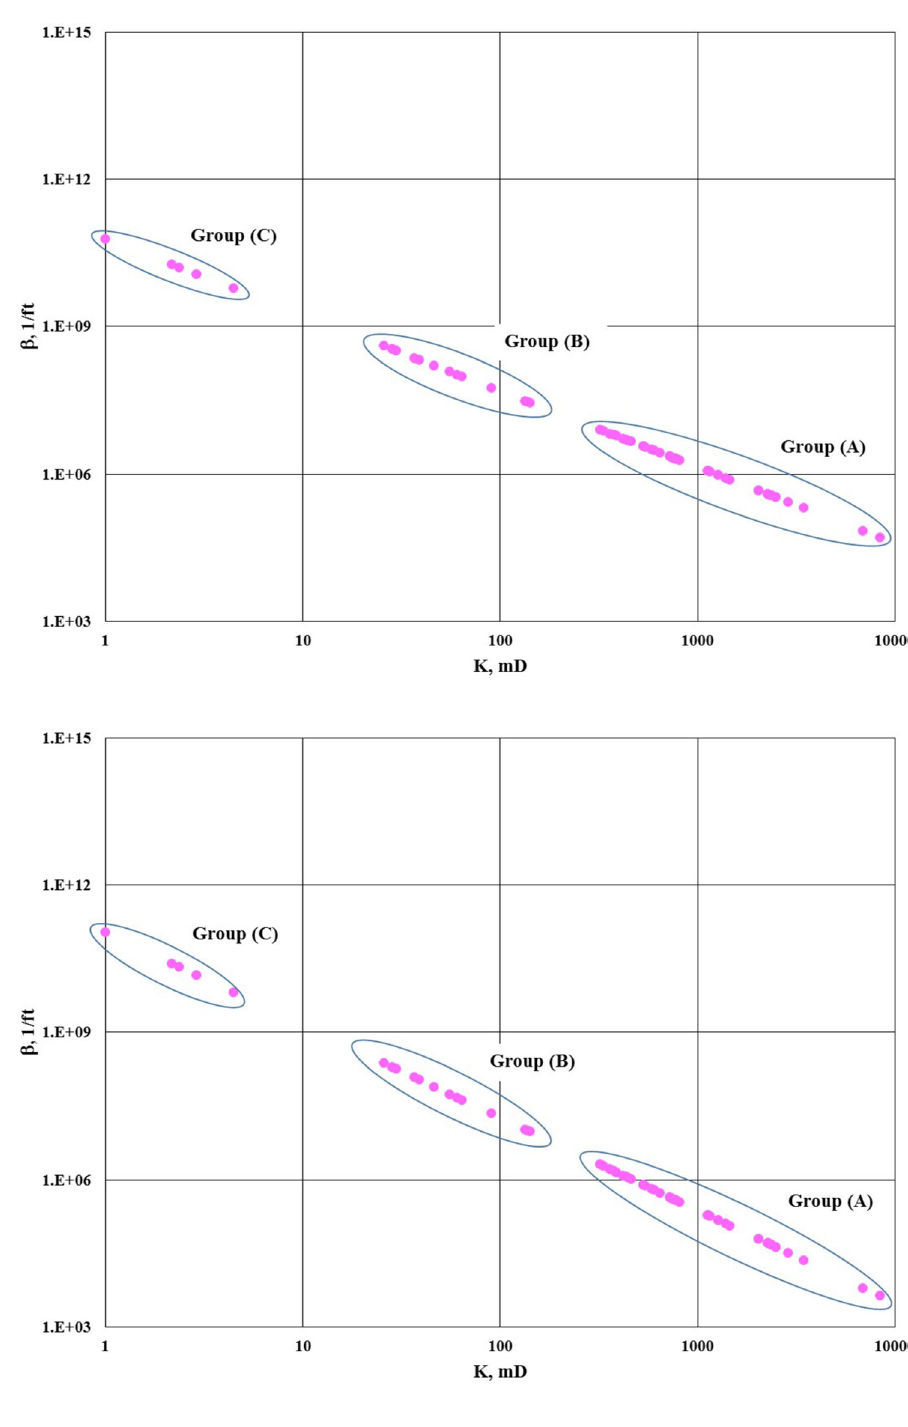
Fig. 4 Turbulence factor versus